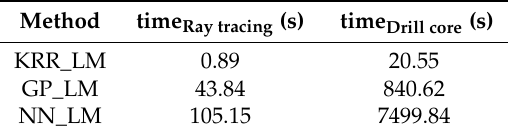
Table 6. The runtime in